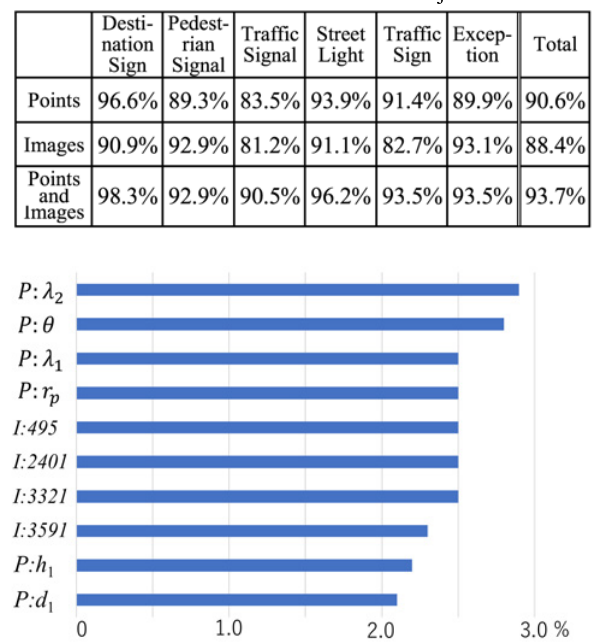
Figure 14: Importance of feature values.